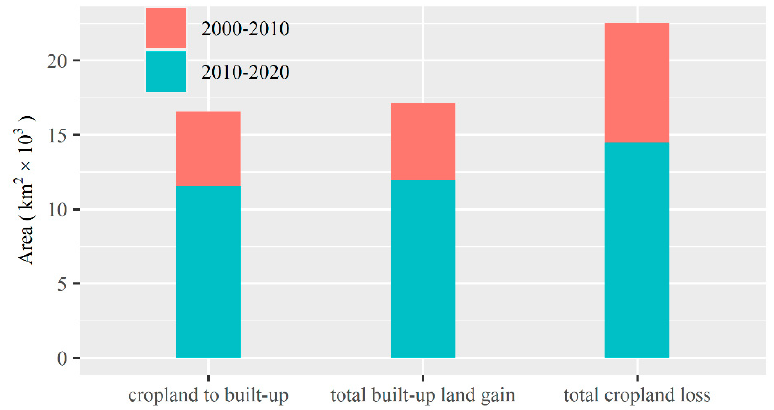
Figure 3. The areas of cropland loss and built-up land gain during the two periods.